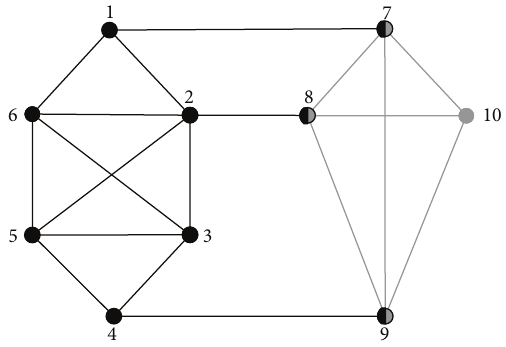
Figure 2: Instance of link